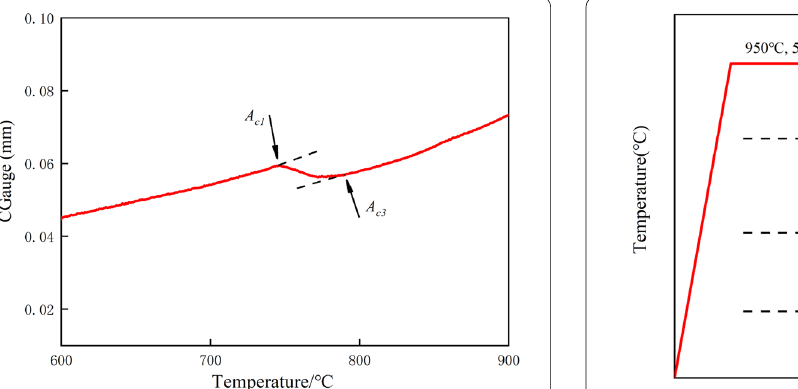
Figure 2 Austenitic thermal expansion curve